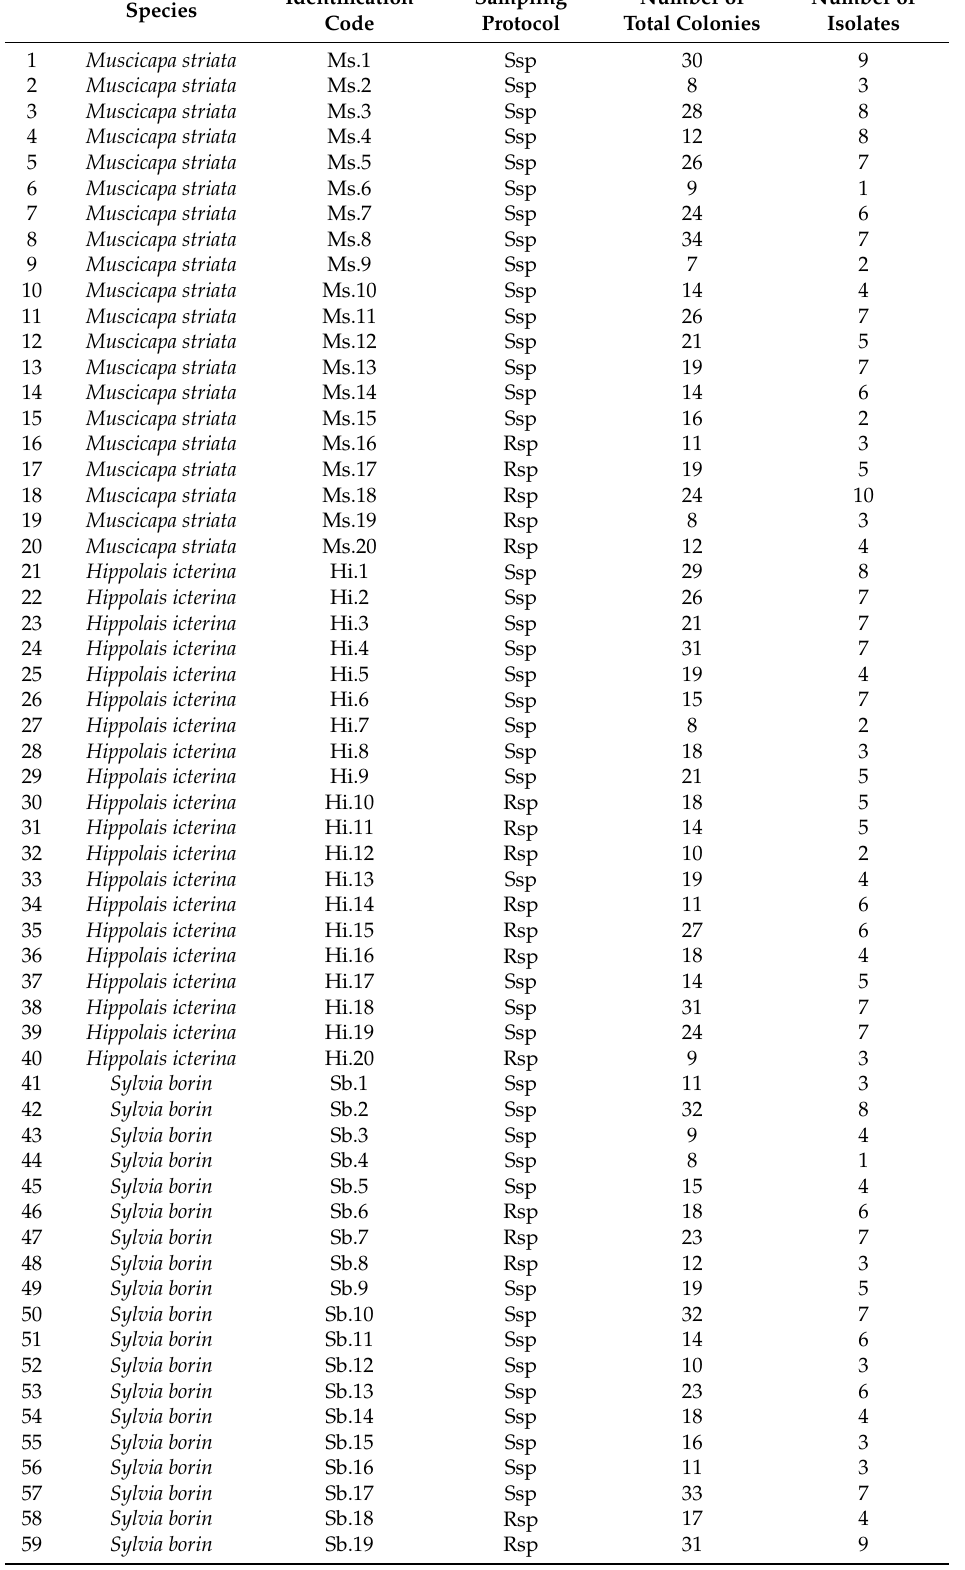
Table 1. Birds species, identification codes, and bacterial sampling protocols adopted. In the sampling protocol column, Ssp = Swab sampling procedure and Rsp = RODAC sampling